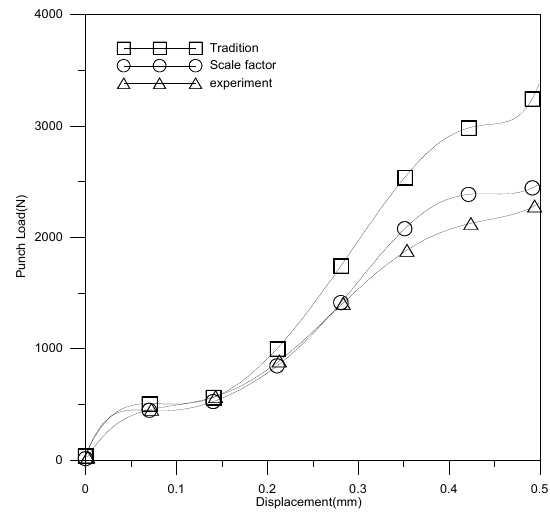
Figure 15. The relationship of punch load and stroke.